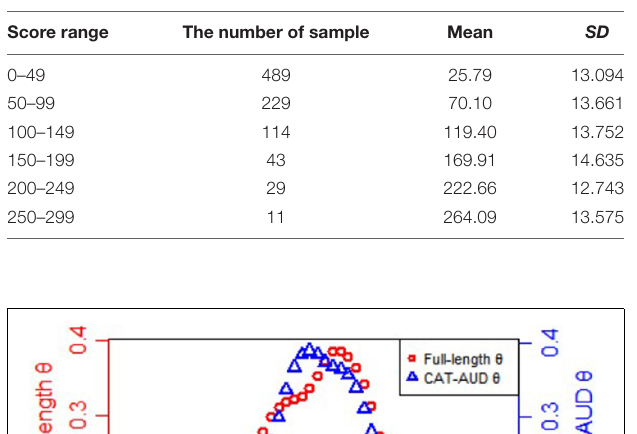
TABLE 4 | The descriptive statistics for the full-length item bank score distribution.